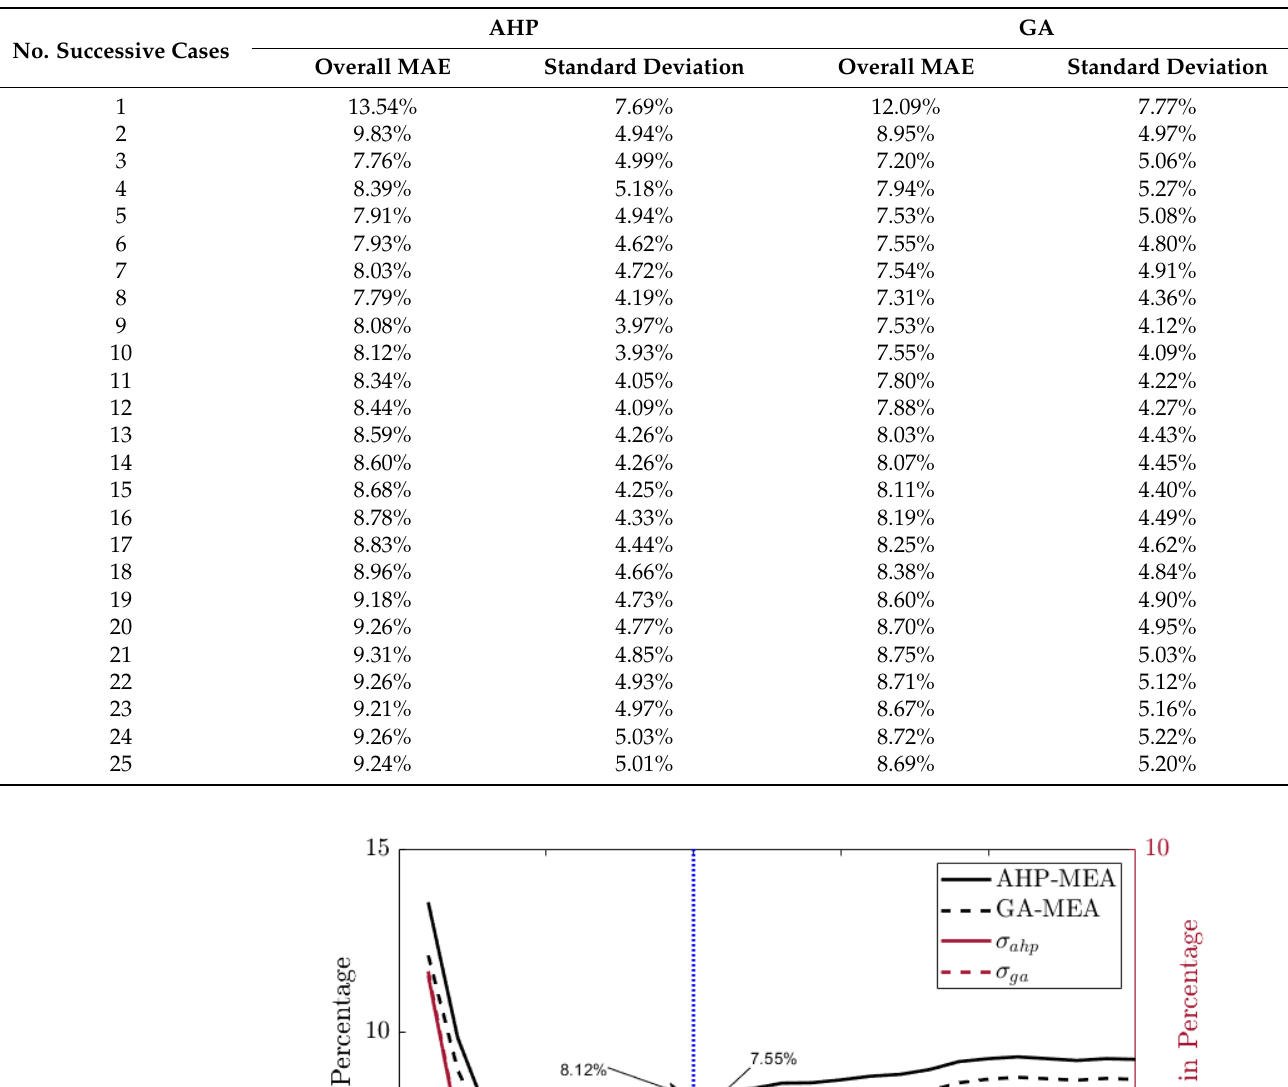
Table 10. Overall MAE and standard deviations of successive cases [59].